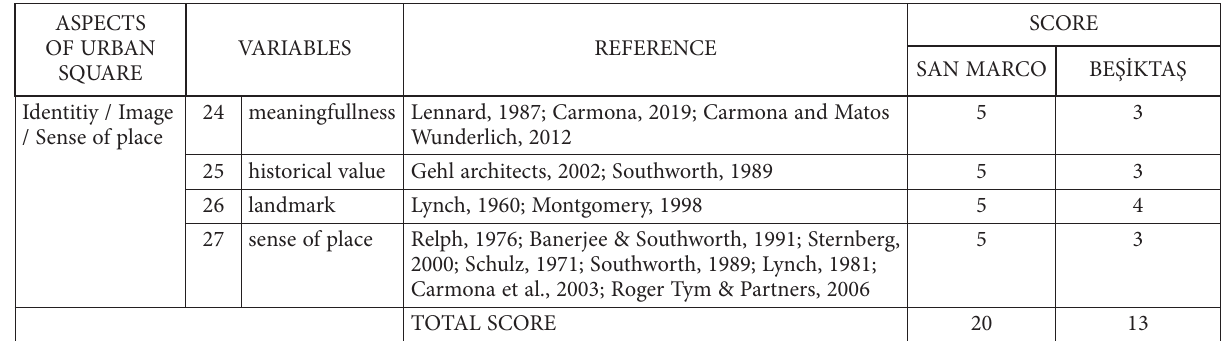
Table 3. Identity / Image / Sense of place quality parameters